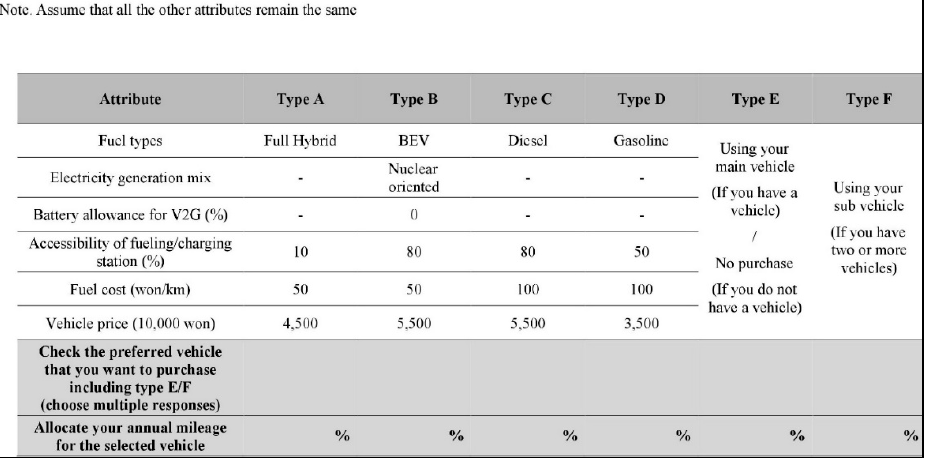
Table 3. Descriptive statistics of the respondents. Characteristics